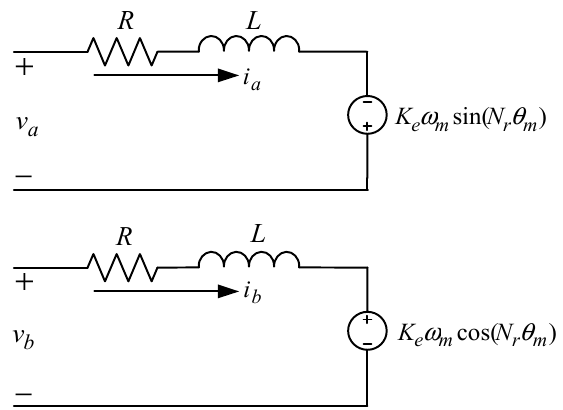
Figure 1. The equivalent stator circuit of two-phase hybrid stepper motor.